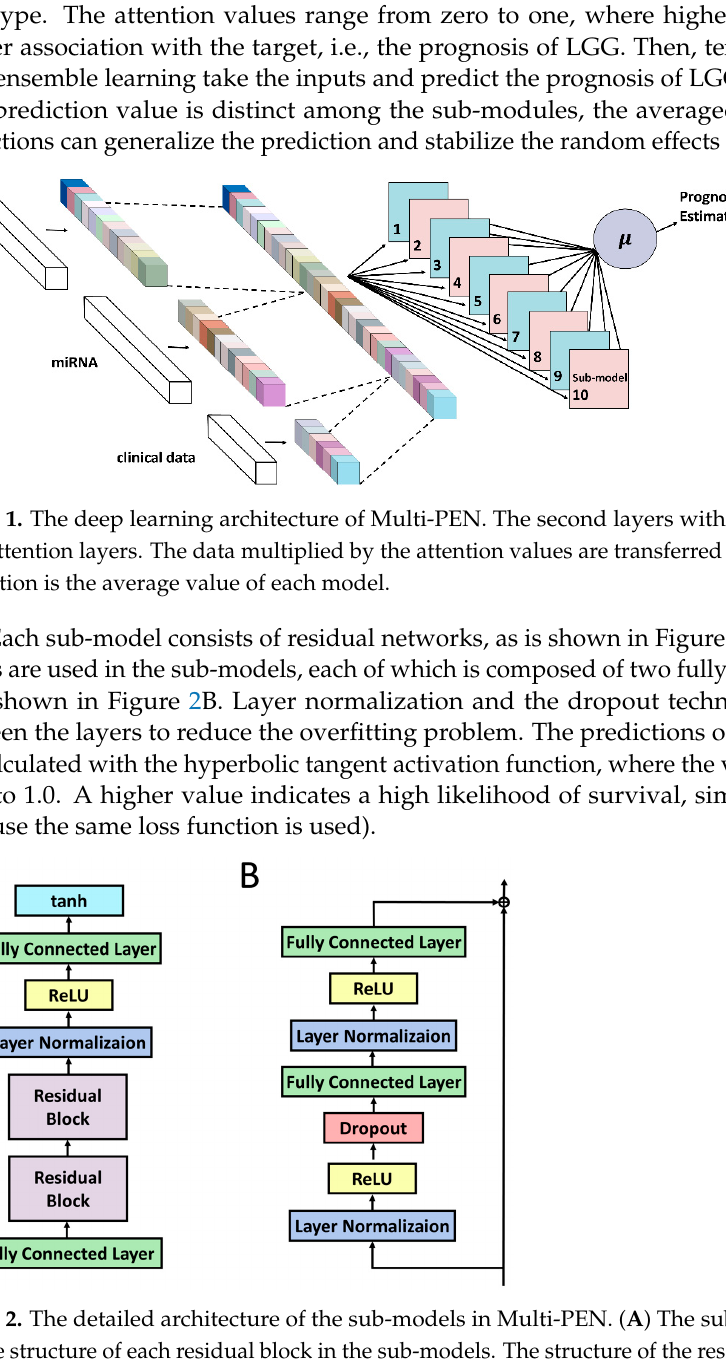
Figure 2. The detailed architecture of the sub-models in Multi-PEN. ( A ) The sub-model structures. ( B ) The structure of each residual block in the sub-models. The structure of the residual block in ( A ) is described in ( B ). The equivalent role organizing in ( A , B ) is colored